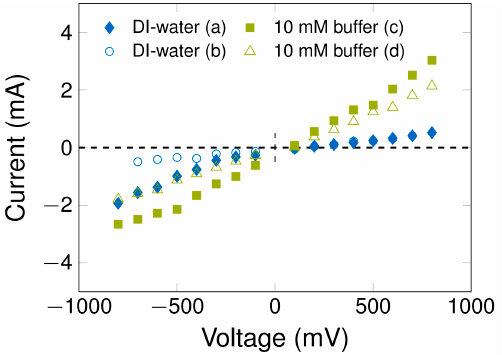
Figure 4. Current / potential diagram to visualize the mean current after EDL rearrangement in a system with DI-water or 10 mM phosphate bu ff er as mobile phase (pH = 7.2, 1 mL / min). The MWCNT matrix was analyzed at an earlier stage (packed bed at initial condition) (a,c) and after long usage (after aging) (b,d). The experiments were performed with column B. The related chronoamperometry measurements and tracer experiments are illustrated in Figures S11 and S12. Information about the electric charge is given in Figures S13 and